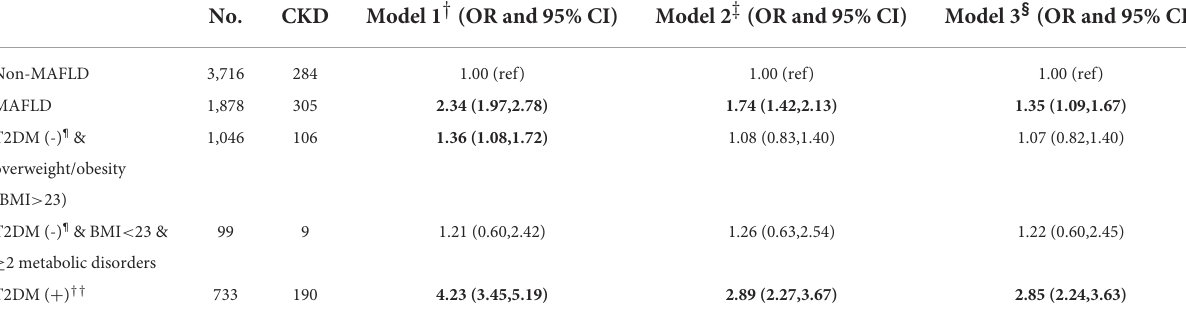
TABLE 2 Association between MAFLD subgroups and